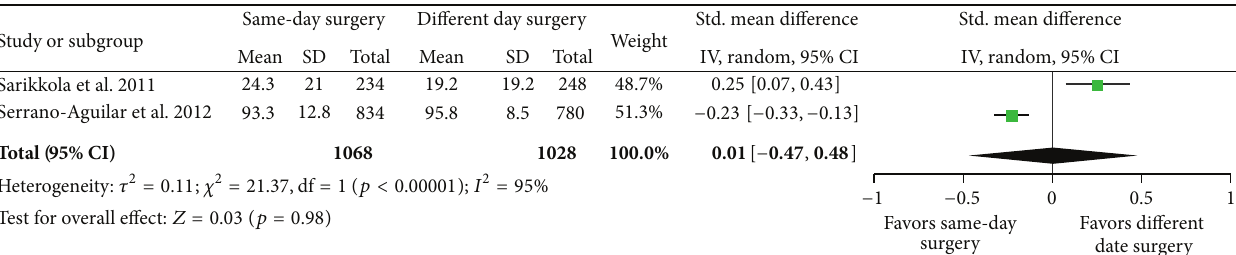
Figure 3: Subjective visual function assessed using the VF-7 (Sarikkola) or VF-14 (Serrano-Aguilar) questionnaire 1 month after bilateral cataract surgery in patients randomized to immediate sequential bilateral cataract surgery (same-day surgery) or different date bilateral cataract surgery. CI: confidence interval. IV: inverse variance. SD: standard